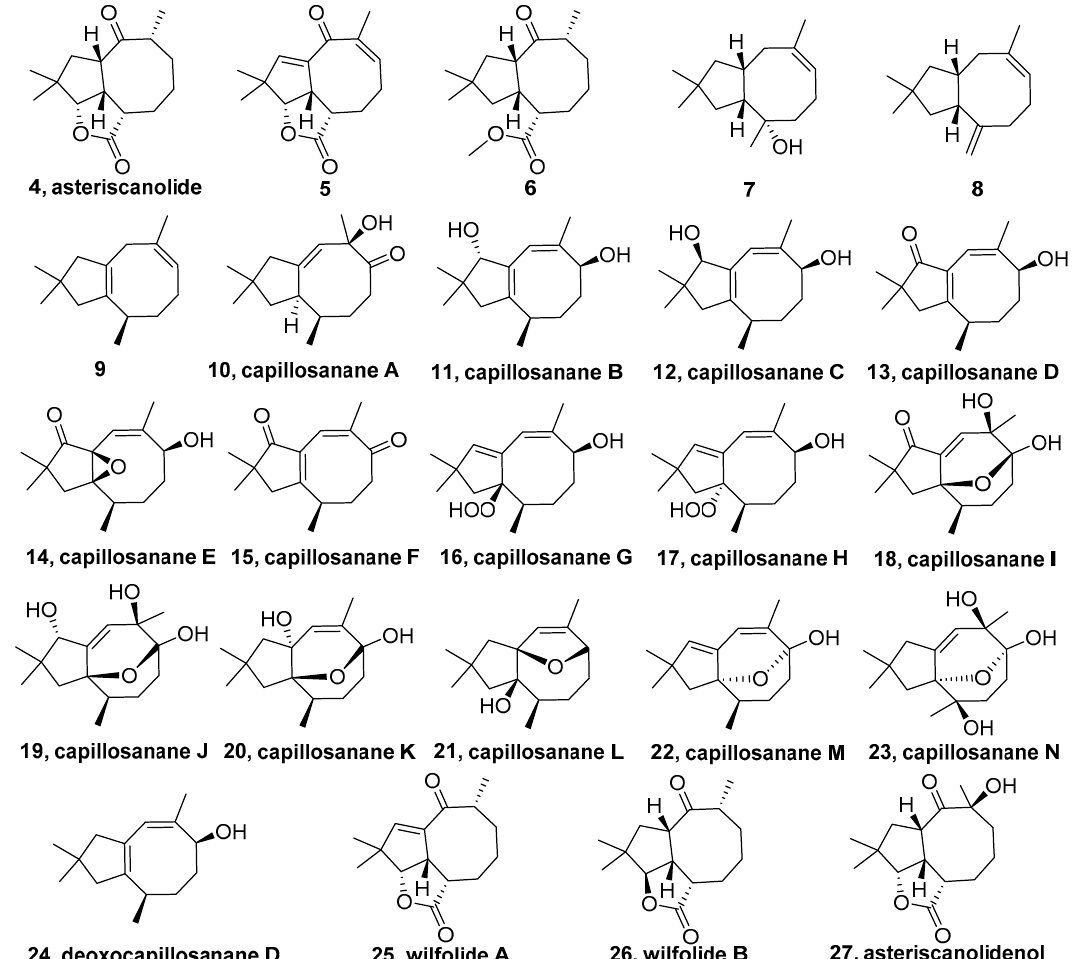
Figure 3. Structures of asteriscane-sesquiterpenoids.